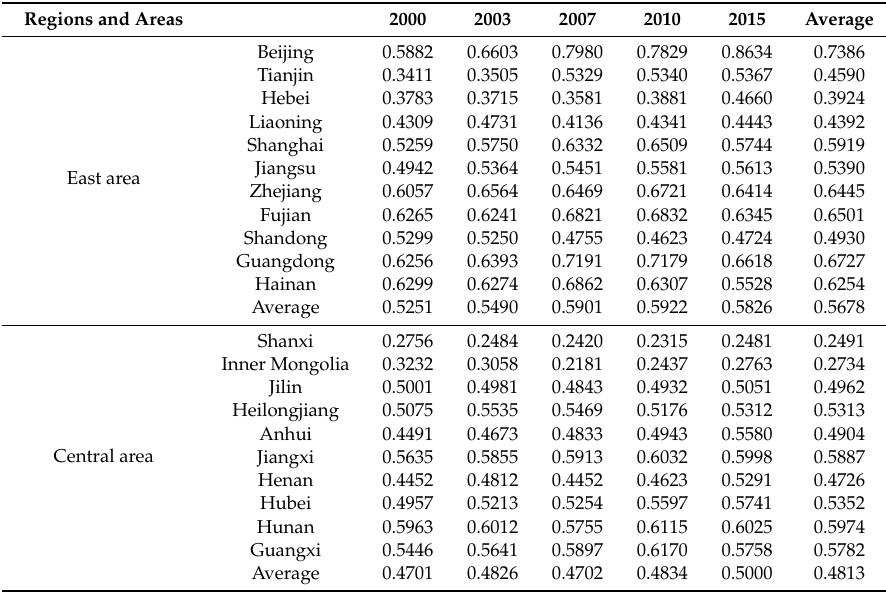
Table 6. Low-carbon economy level in